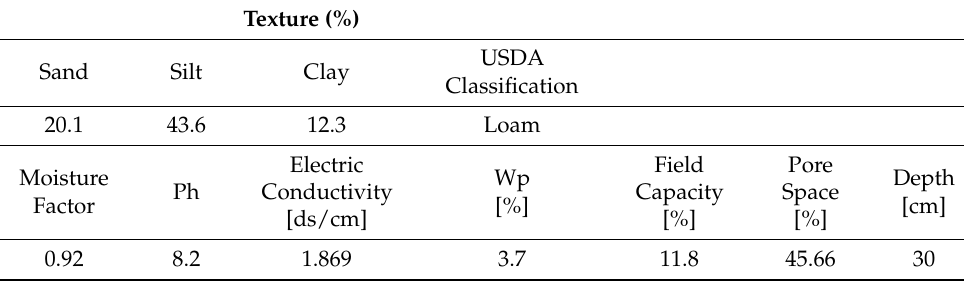
Table 1. Soil properties in pilot